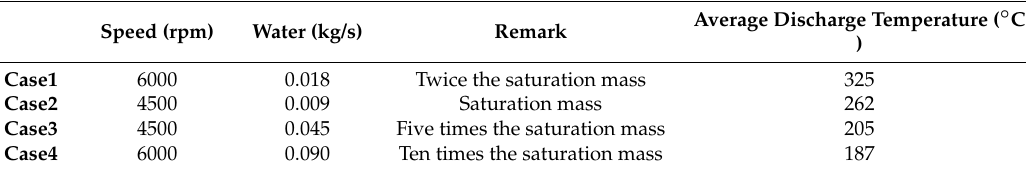
Table 1. Evaluated CFD cases and resultant discharge temperatures at 11.0 bar.